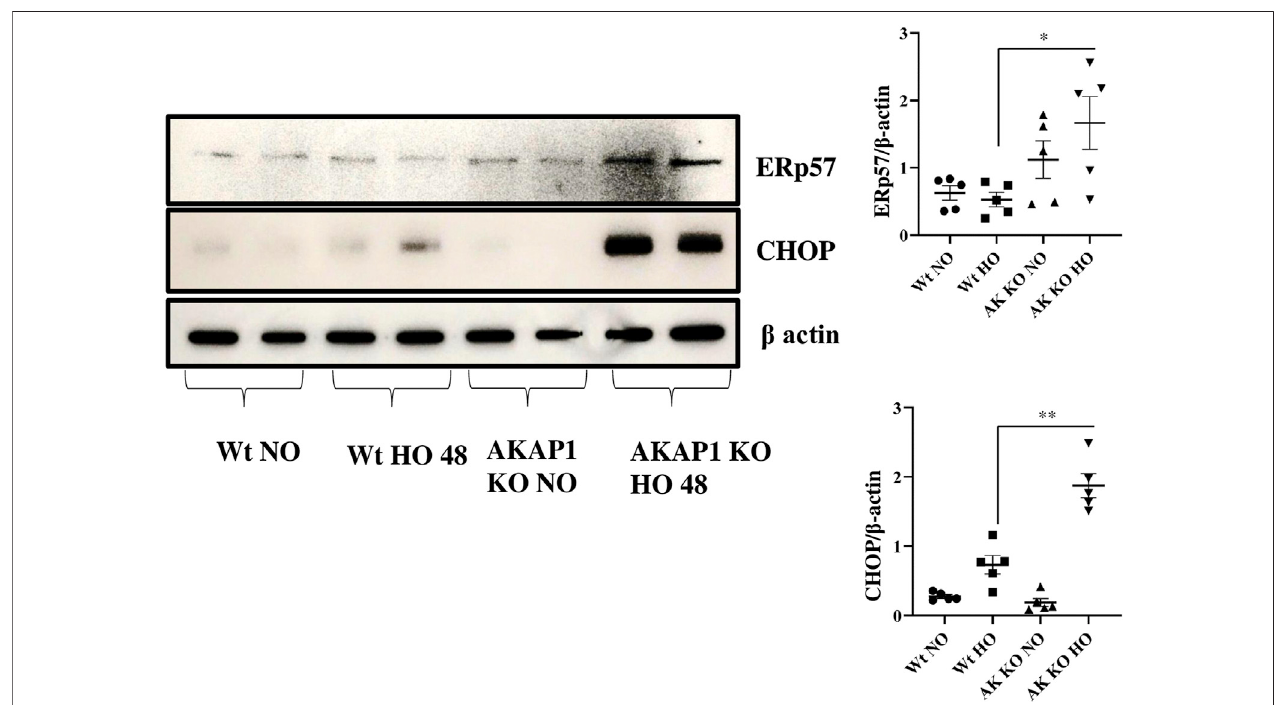
FIGURE5| Akap1 geneticdeletionenhancesERstress-inducedcelldeathafterhyperoxicexposure: Wt and Akap1 micewereexposedtonormoxiaandhyperoxia for 48 h. After hyperoxia, the mice were killed, and protein wasextracted from the lungs and subjected to Western blot analysis toevaluate the expression of CHOP and Erp57. β -actinwasusedasaloadingcontrol.DensitometryanalysisofCHOPandErp57proteinwasfollowedbynormalizationto β -actin.Dataareexpressedasmean± SEM (* p < 0.05, ** p < 0.005) ( n = 5 mice per group). NO, normoxia; HO, hyperoxia; AK, Akap1 ; KO: expression ( Figure 2 ) in Akap1 − / − versus Wt mice exposed to hyperoxia in the lung lysates subjected to Western blot analysis.